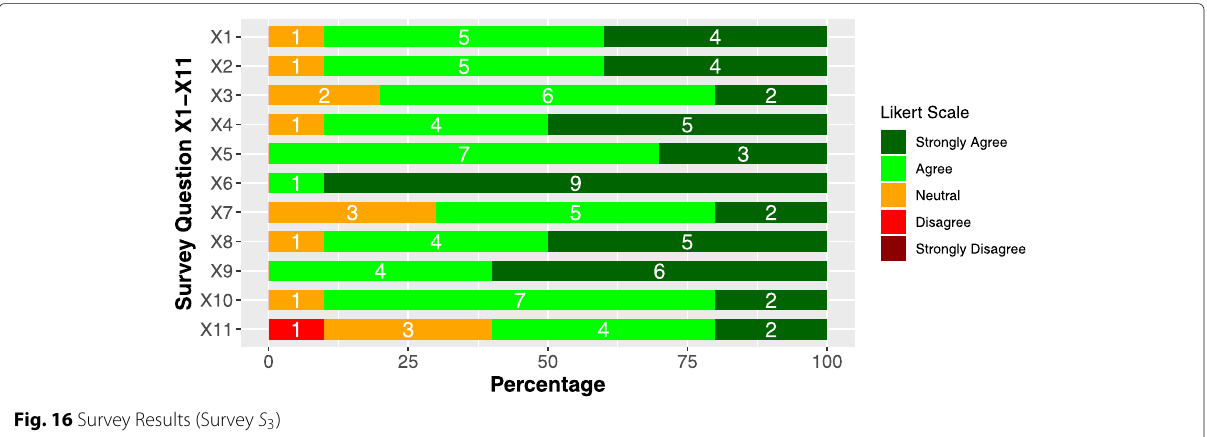
Fig. 16 Survey Results (Survey S 3